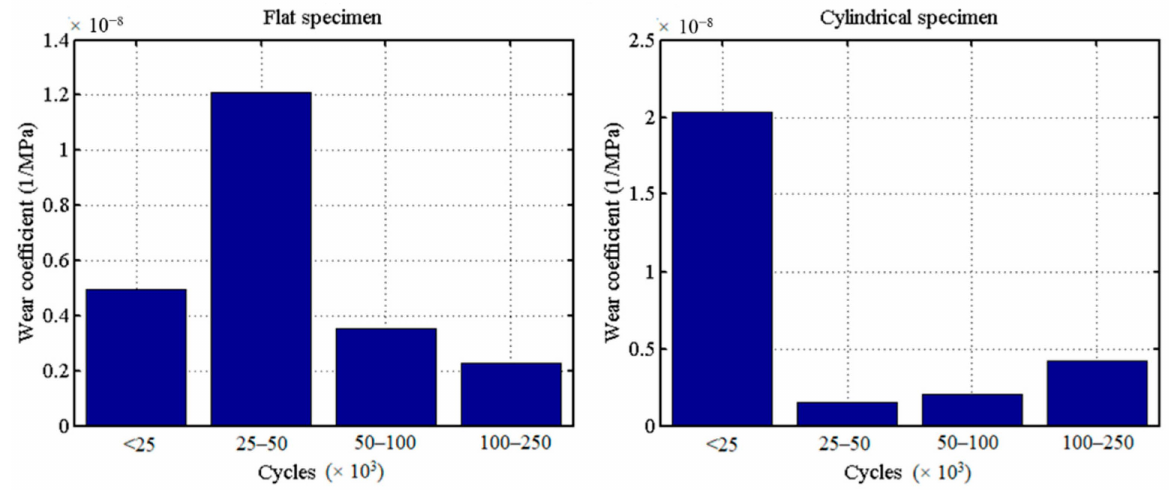
Figure 11. Experimental wear coefficient in certain cycles’ interval: ( a ) flat specimen, ( b ) cylindrical pad.